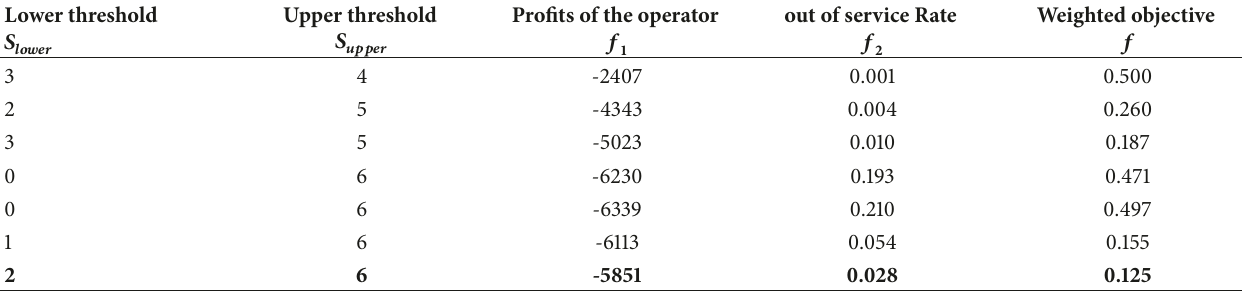
Table 2: The nondominated solutions set and the final decision under weighted method.